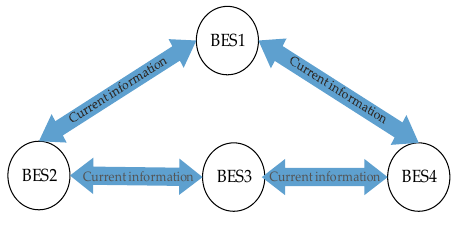
Figure 12. Topological structure of four groups of energy storage communication. Table 1. Operational situations of DC microgrid.